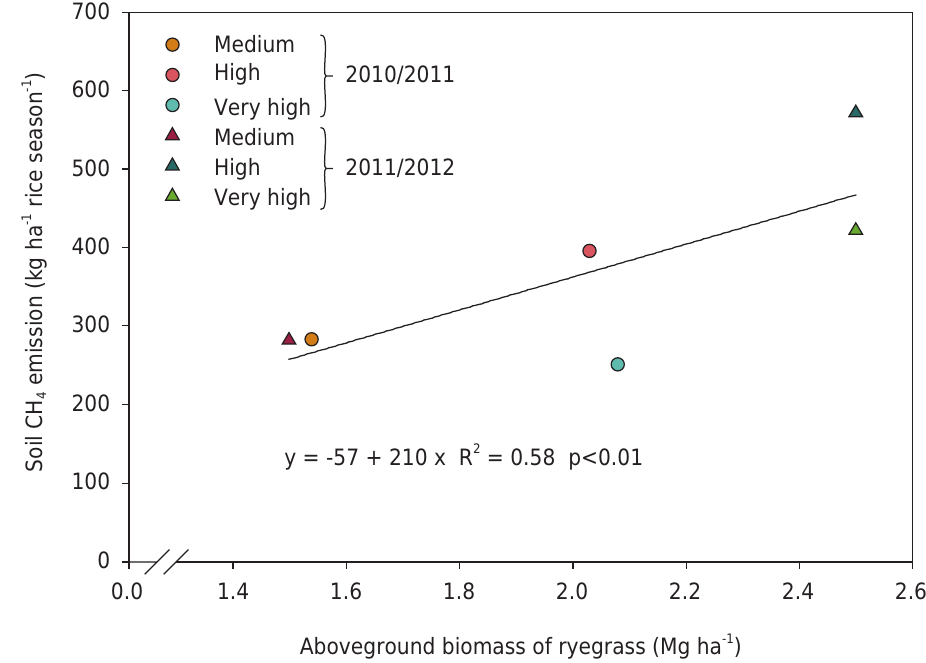
Figure 5. Relationship between aboveground ryegrass biomass in the previous winter (non-rice season) and cumulative soil CH 4 emissions during the subsequent rice season in southern